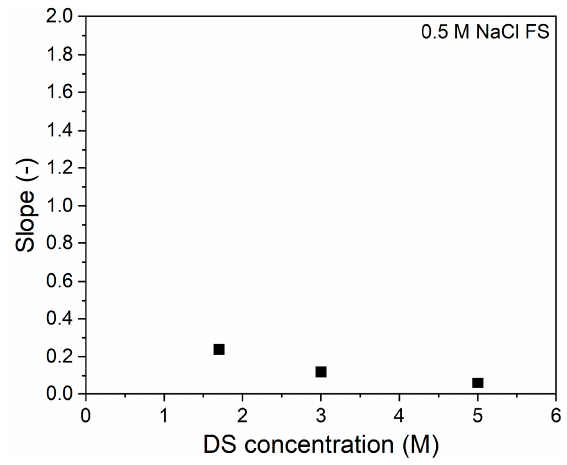
Figure 6. Slopes of the water flux vs. osmotic pressure difference between bulk DS and FS at each DS concentrations. FS: 0.5 M NaCl FS.